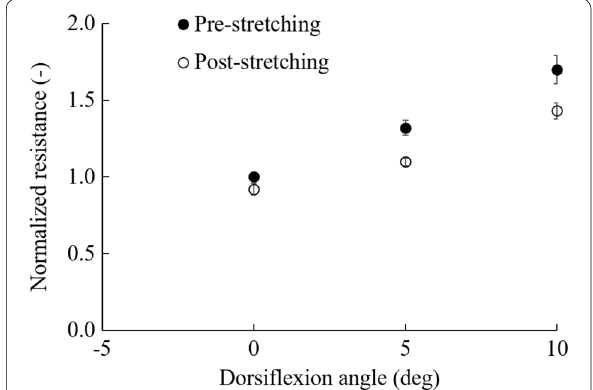
Fig. 6 Passive resistance. Passive resistance decreased significantly after stretching ( p < 0.001 ). Error bars represent standard